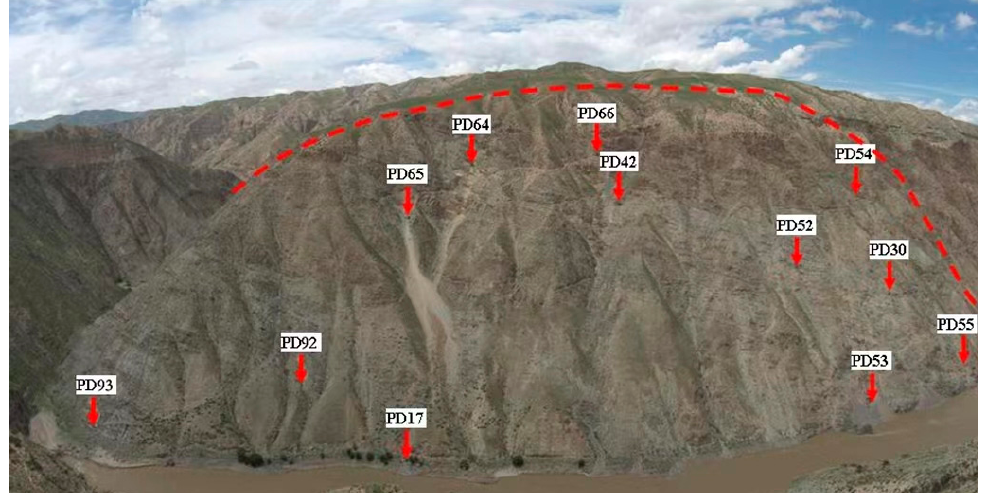
Figure 8. Layout of a typical dumping body exploration flat. Table 1. Summary of lithological distribution of the slope.